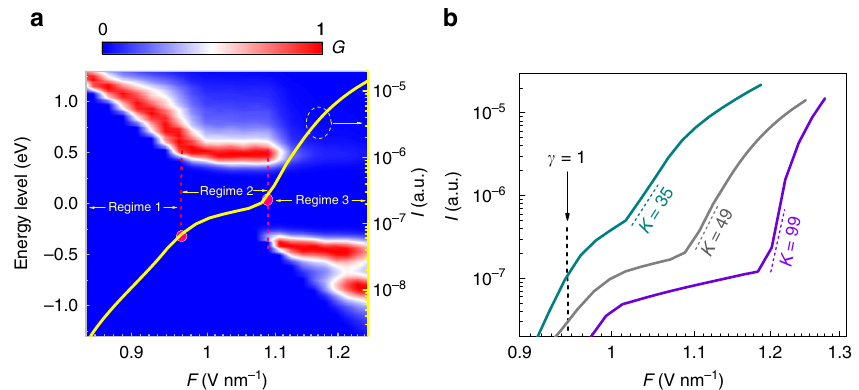
Fig. 4 Illustration of bandgap dependency by Simpleman model calculation. a Contour plot of the F- dependent number ( G , normalized at each F point) of emitted electrons from different energy levels, for a CNT model with a bandgap of ~1.0 eV. I – F curve (solid yellow line) is plotted. Transition points between different regimes are marked by red points. A transition point at F ≈ 1.1 V nm − 1 is noted, before which the electrons mainly emit from CB states (above zero energy level), after which the electrons mainly emit from VB states (below zero energy level). At the same point, an upward bending of the I – F curve occurs. b I – F curves of three CNT models with different bandgaps: left (cyan) — 0.5 eV, middle (gray) — 1.0 eV, and right (purple) — 1.5 eV. Higher bandgap is associated with greater nonlinearity. Note that the FN model-based simulation is only valid when γ < 1, which is the OFE regime. Here, we plot a longer F range to clearly show the transition from CB-OFE to VB-OFE. The multiphoton photoemission is not considered in low driving fi eld limit ( γ > 1) in the present